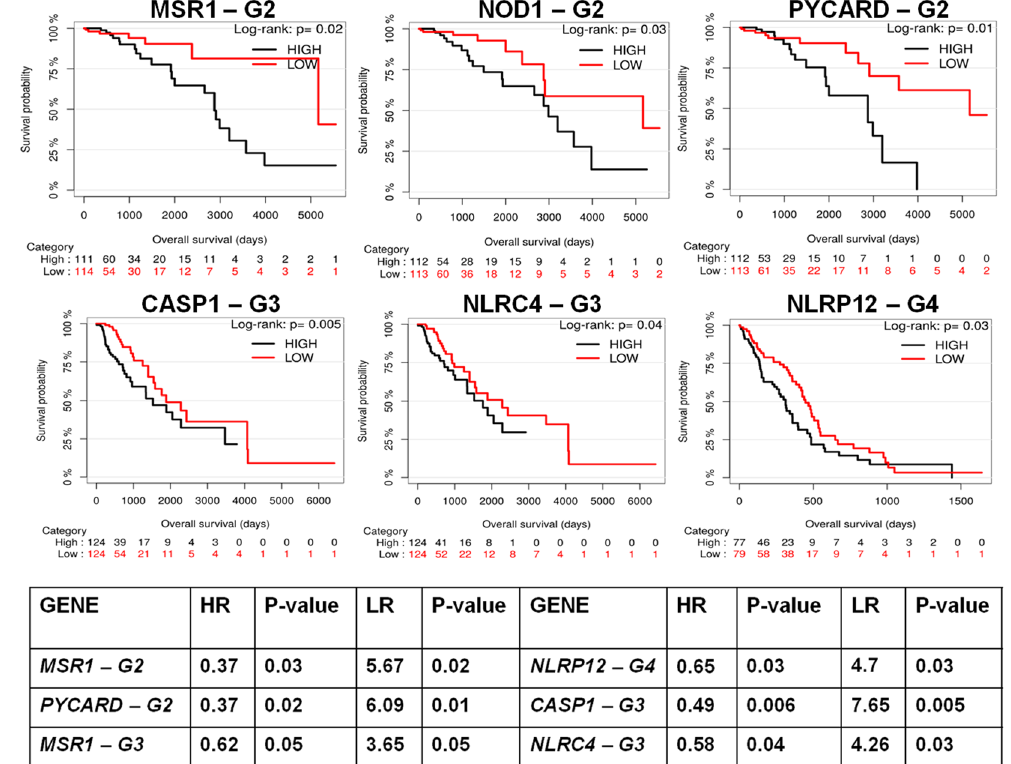
Figure 6. Kaplan-Meier survival curves of low grade glioma and glioblastoma patients stratified by the expression of NLRs. The survival curves show significant association of NLRs and other related genes with patient survival. Here, G2, G3 and G4 represents grade 2, grade 3, and grade 4 respectively. The table (below) represents hazard ratio (HR) and Likelihood ratio (LR) for most significantly expressed genes in glioma. Here, the P-values indicate level of significance of the HR and LR calculated for the corresponding